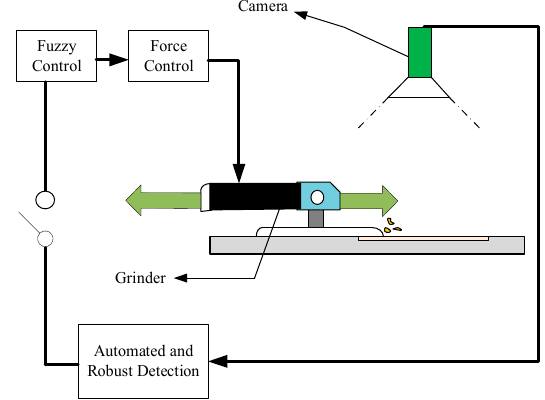
Figure 11. Visual servo sanding structure.